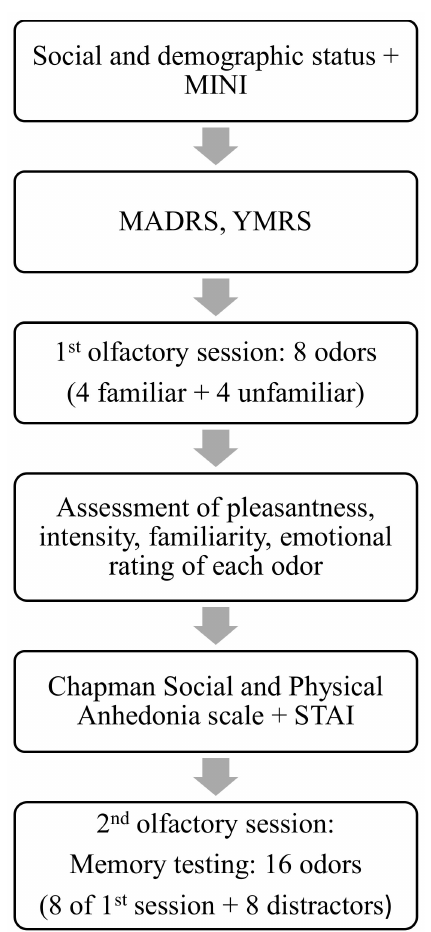
Figure 2. Consecutive steps of the assessment process. MADRS: Montgomery–Åsberg Depression Rating Scale; MINI: Mini-International Neuropsychiatric Interview; STAI: State–Trait Anxiety Inventory; YMRS: Young Mania Rating